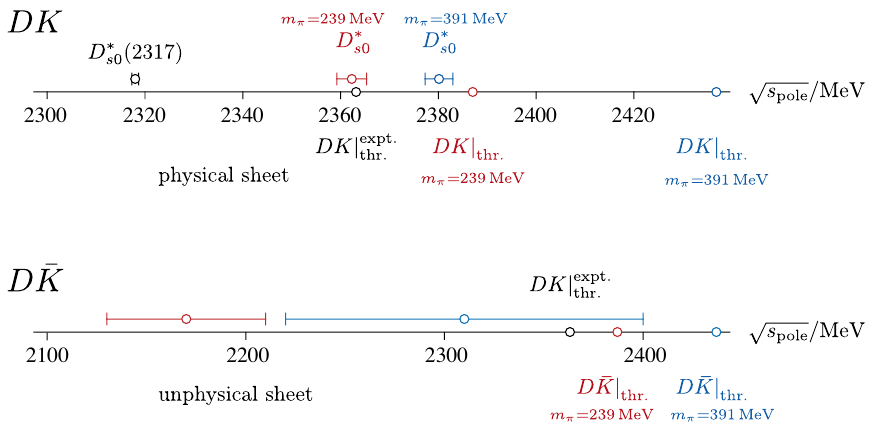
Figure 19 . A summary of the S -wave poles found in this work. The top panel shows the bound- state poles found on the physical sheet in the I = 0 DK scattering amplitudes with the experimental D ∗ (2317) and threshold from ref. [51]. The lower panel shows the virtual bound-state poles found s 0 on the unphysical sheet in the exotic I = 0 D ¯ K scattering amplitudes; note that not all the amplitudes for m π = 239 MeV produced such a